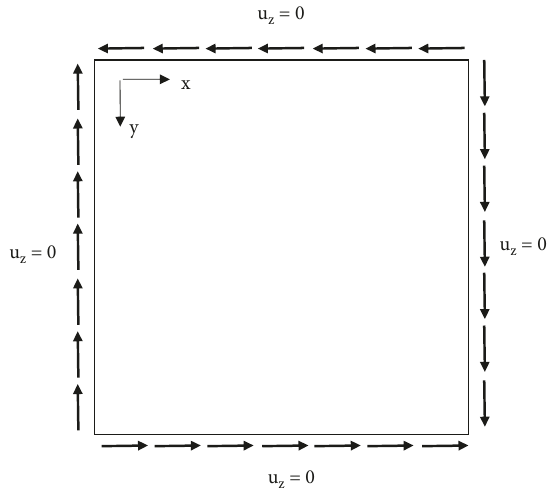
Figure 1: Shear buckling load and simply supported boundary condition of the present model.